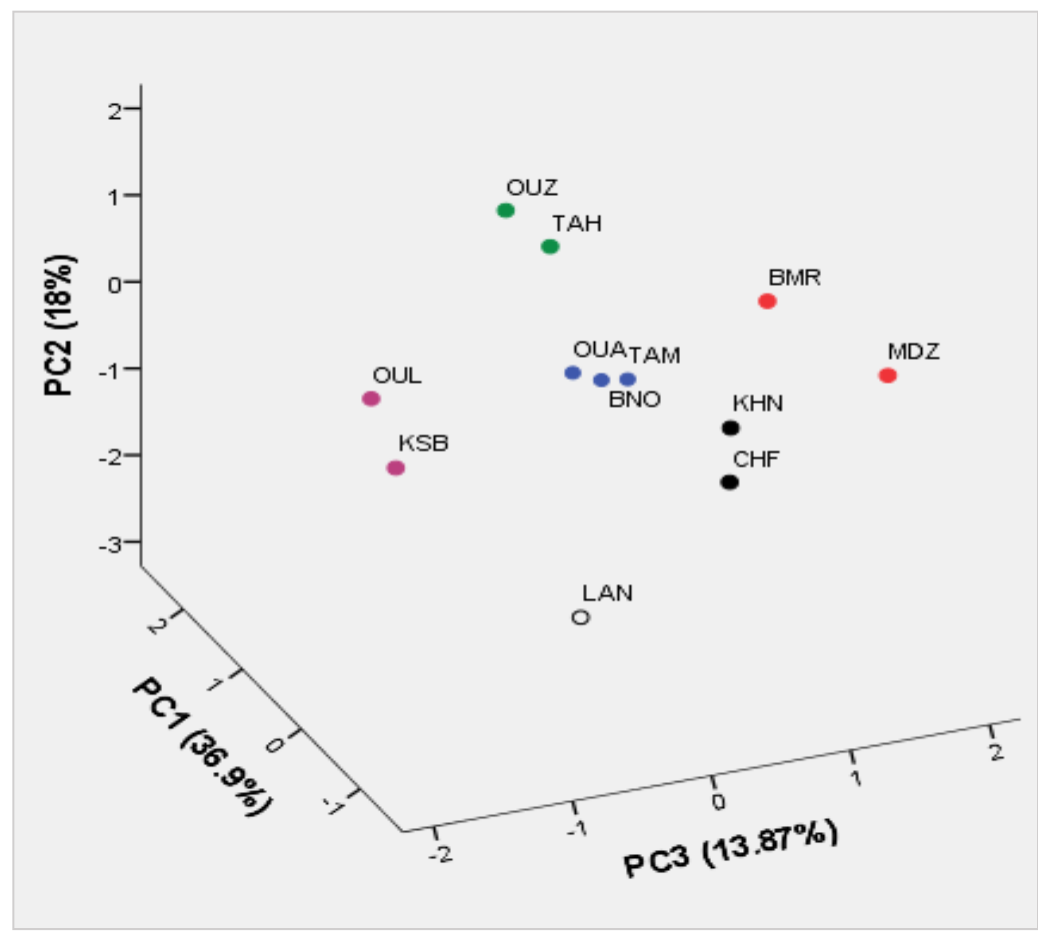
Figure 2. Scatter plot for the first three principal components (PC1/PC2/PC3, 68.77% of total variance) for the studied strawberry tree genotypes based on their biochemical parameters.